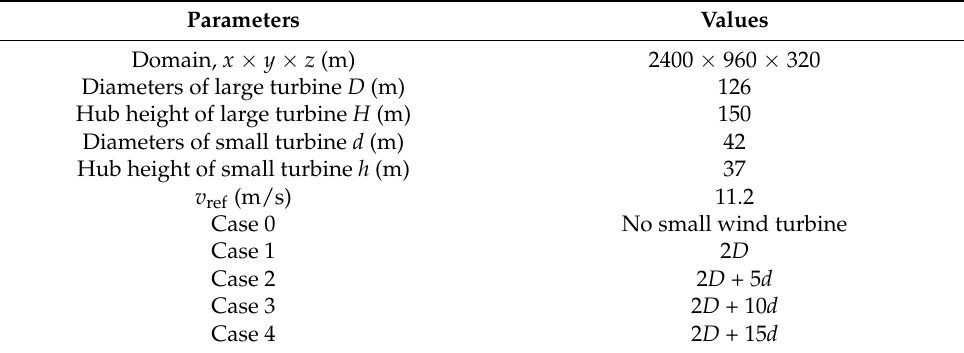
Figure 1. Sketch of the wind turbine layout for different cases. Table 1. Wind farm and turbine parameters and layout.